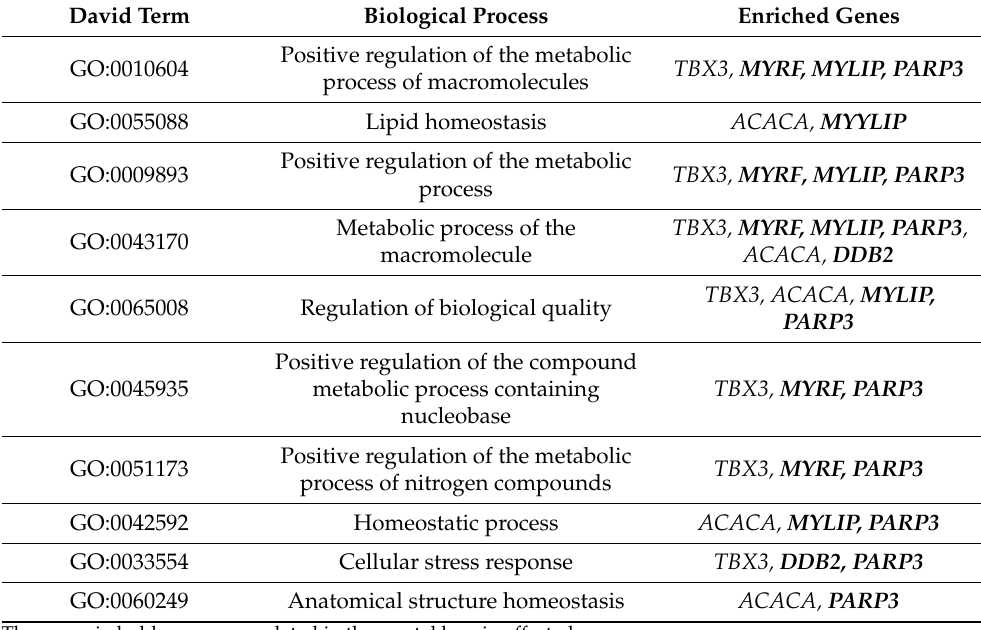
Table 9. Biological processes enriched with genes harboring SNPs in the scrotal hernia